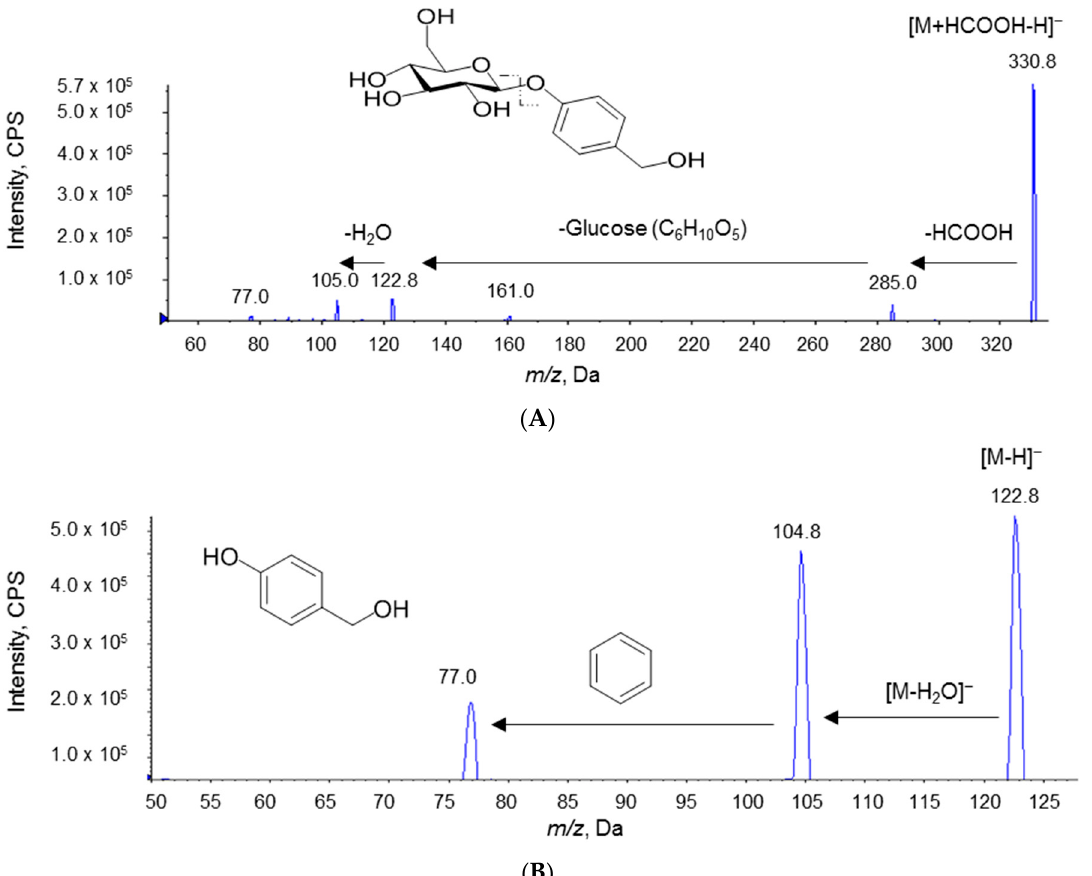
Figure 1. Chemical structures and product ion spectra of gastrodin ( A ) and 4-hydroxybenzyl alcohol ( B ).